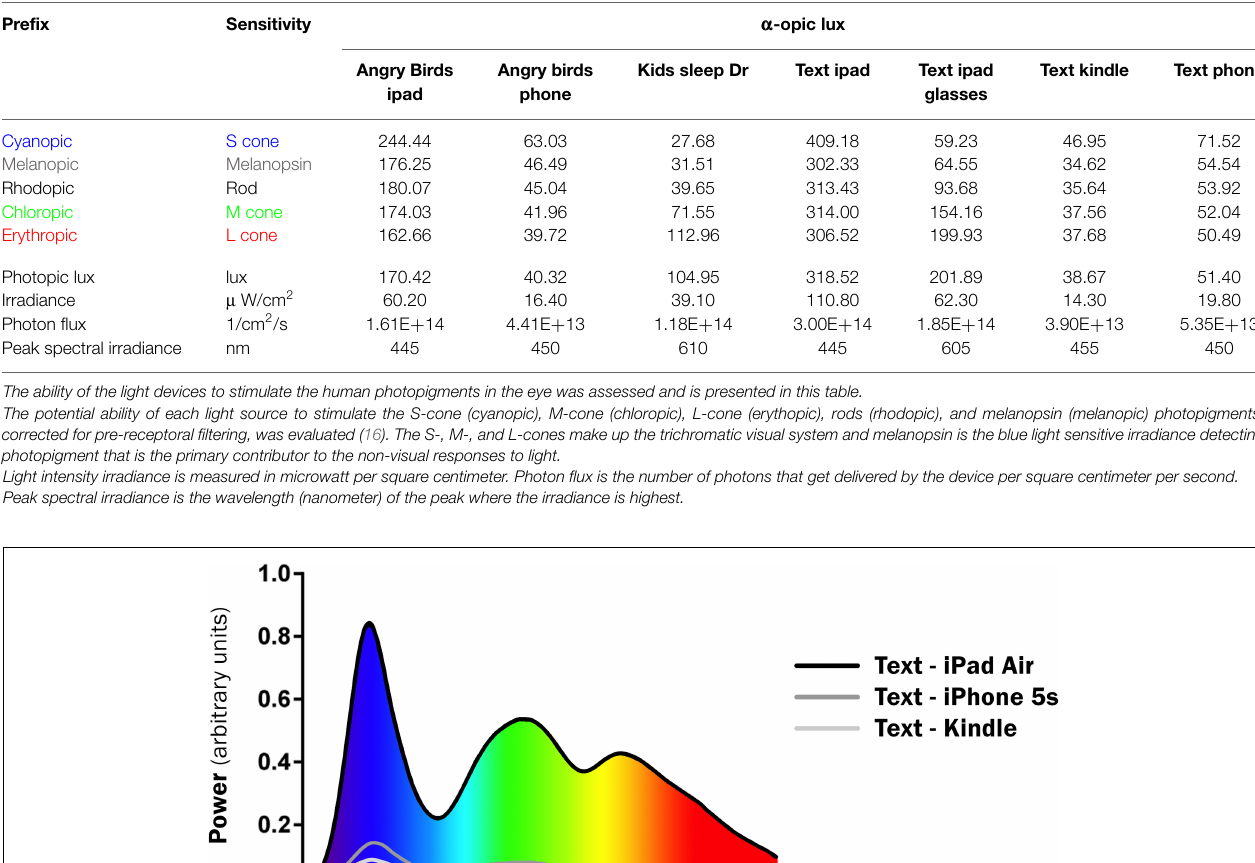
TABLE 2 | Spectral distribution of human retinal photopigment-weighted measures from all light-emitting devices during different display conditions .